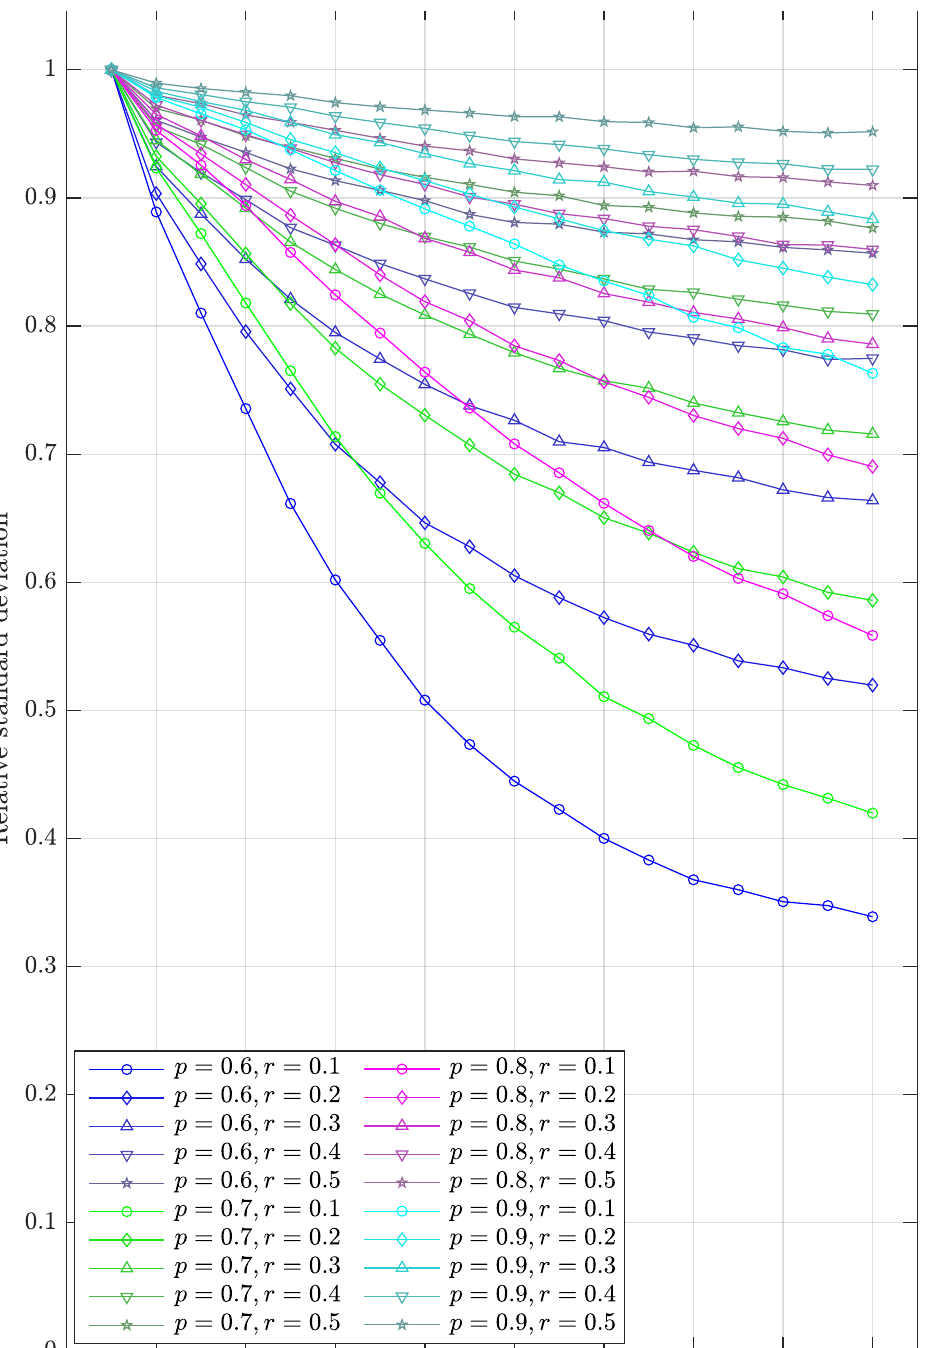
Figure 11. Relative standard deviation (heteroskedastic rms over homoskedastic rms) of the curvature κ for p T = 100,GeV/ c , λ = π /4 and all 20 combinations of p and r in the range 3 ≤ n ≤